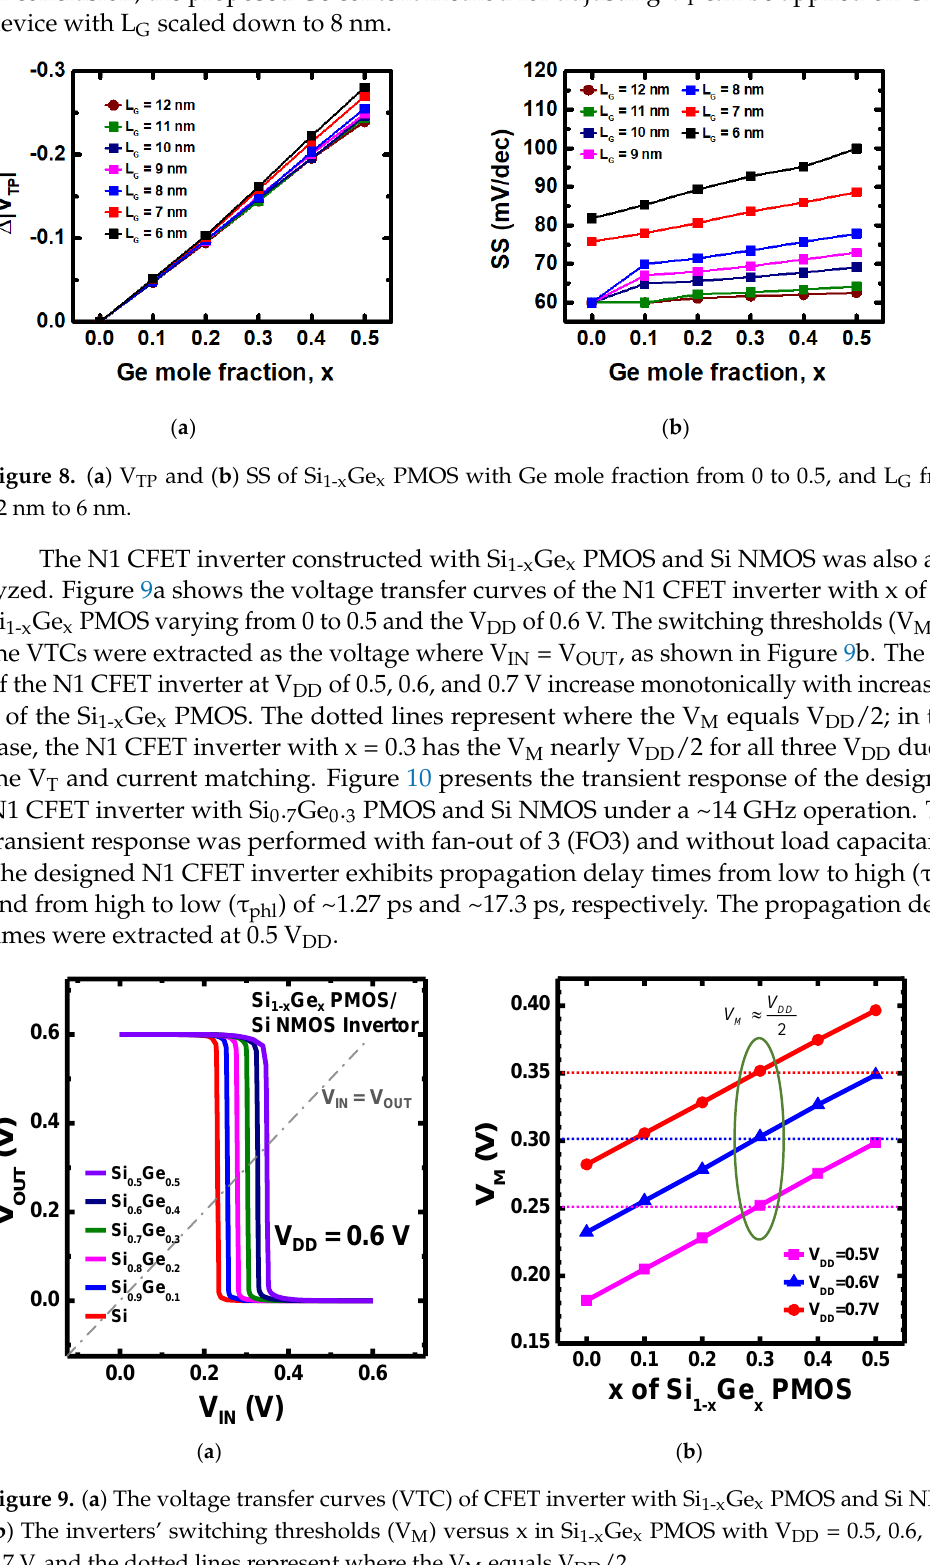
Figure 10. Transient response of the designed N1 CFET inverter with Si 0.7 Ge 0.3 PMOS and Si NMOS under a ~14GHz operation. Moreover, the designed N1 CFET inverter with Si 0.7 Ge 0.3 PMOS and Si NMOS was used to build a 6T-SRAM cell. The 6T-SRAM cell was constructed with two N1 CFET in- verters and two NMOS access transistors. The butterfly curves of the 6T-SRAM built with N1 CFET inverters at V DD of 0.5, 0.6, and 0.7 V are shown in Figure 11. Excellent stability is present with a large static noise margin (SNM) of ~120 mV as V DD down to 0.5 V, and the SNM values are ~140 and ~155 mV at V DD of 0.6 and 0.7 V, respectively.